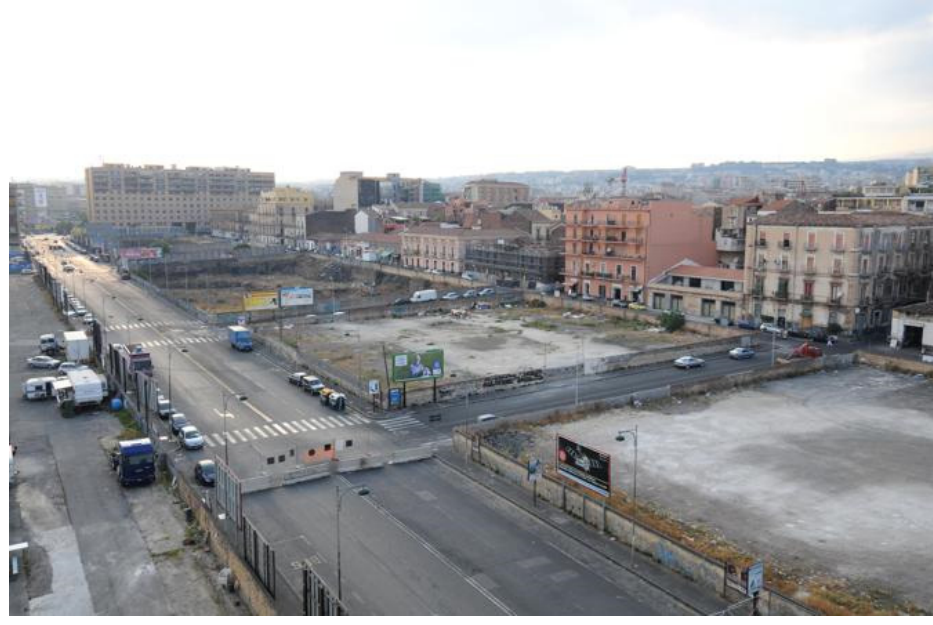
Figure 12. Corso Martiri della libertà—Catania (before).